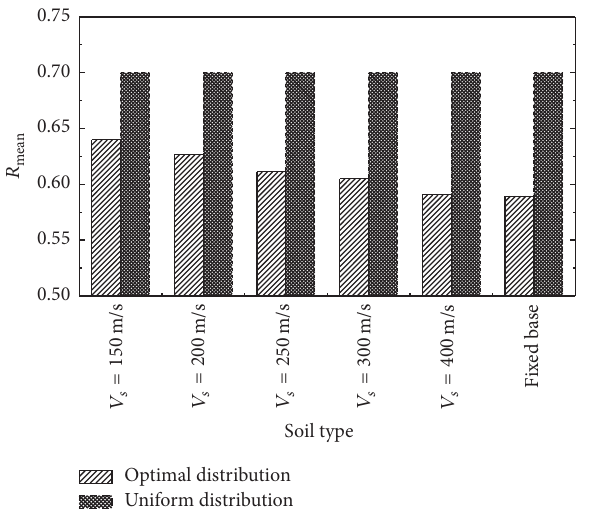
Figure 18: The comparison of 𝑅 mean between optimal distribution and uniform distribution of VEDs (20-story